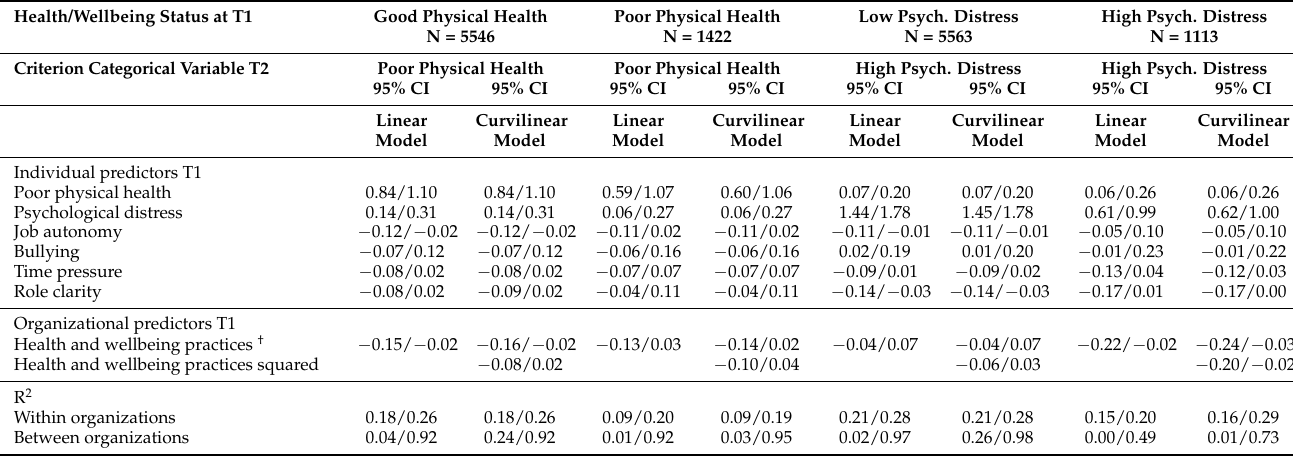
Table 5. 95% credibility intervals of regression coefficients and variance accounted for multilevel probit linear and curvilinear regression analyses with Bayesian